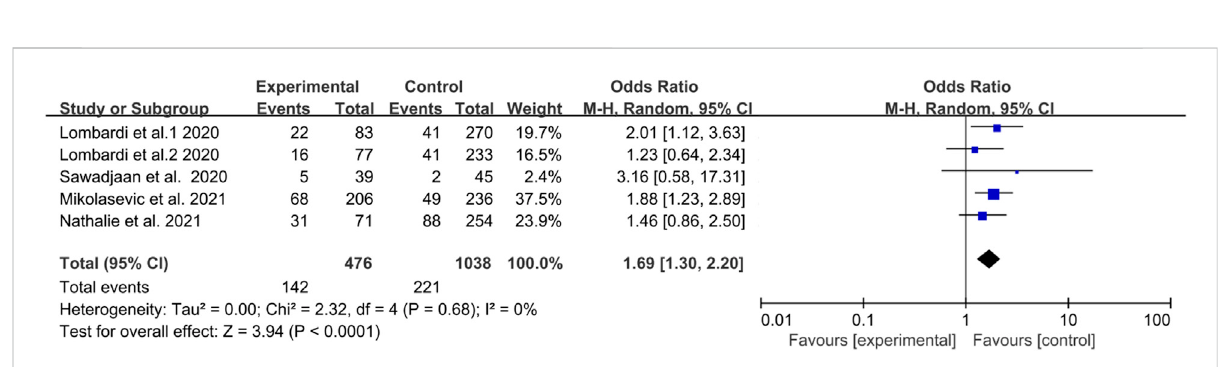
FIGURE 3 Meta-analysis of association between liver fi brosis and the risk of diabetic retinopathy in diabetes